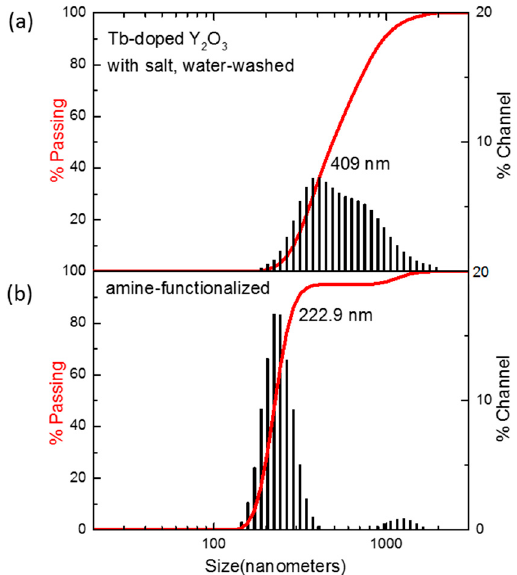
Figure 11. Particle size distributions of ( a ) Y 2 O 3 :Tb 3 + nanoparticles prepared with salt and water washing; ( b ) Y 2 O 3 :Tb 3 + @silica particles functionalized with aminopropyl groups.